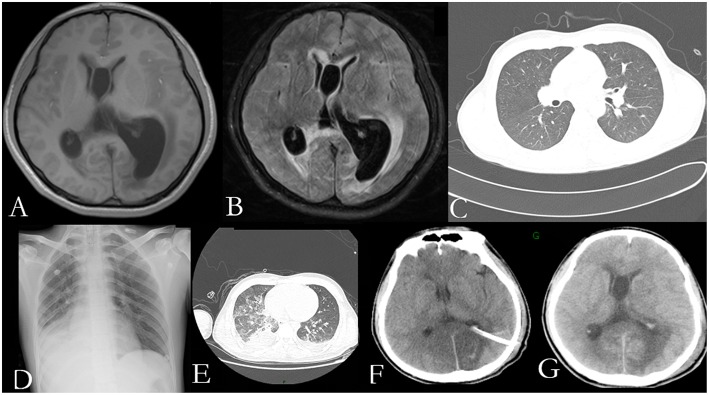
Radiological examination of the patient: T1 weighted axial and T2-flair brain MR imaging showing pachymeningitis and hydrocephalus (A,B); The lung CT on the first day of his second admission shows no obvious signs of inflection (C); The chest radiograph (D); and lung CT (E) show pulmonary infection, pleural effusion, and partial atelectasis; Head CT on the first day after surgery (F) and a week after surgery (G) show rapid accumulation of cerebrospinal fluid (CSF).